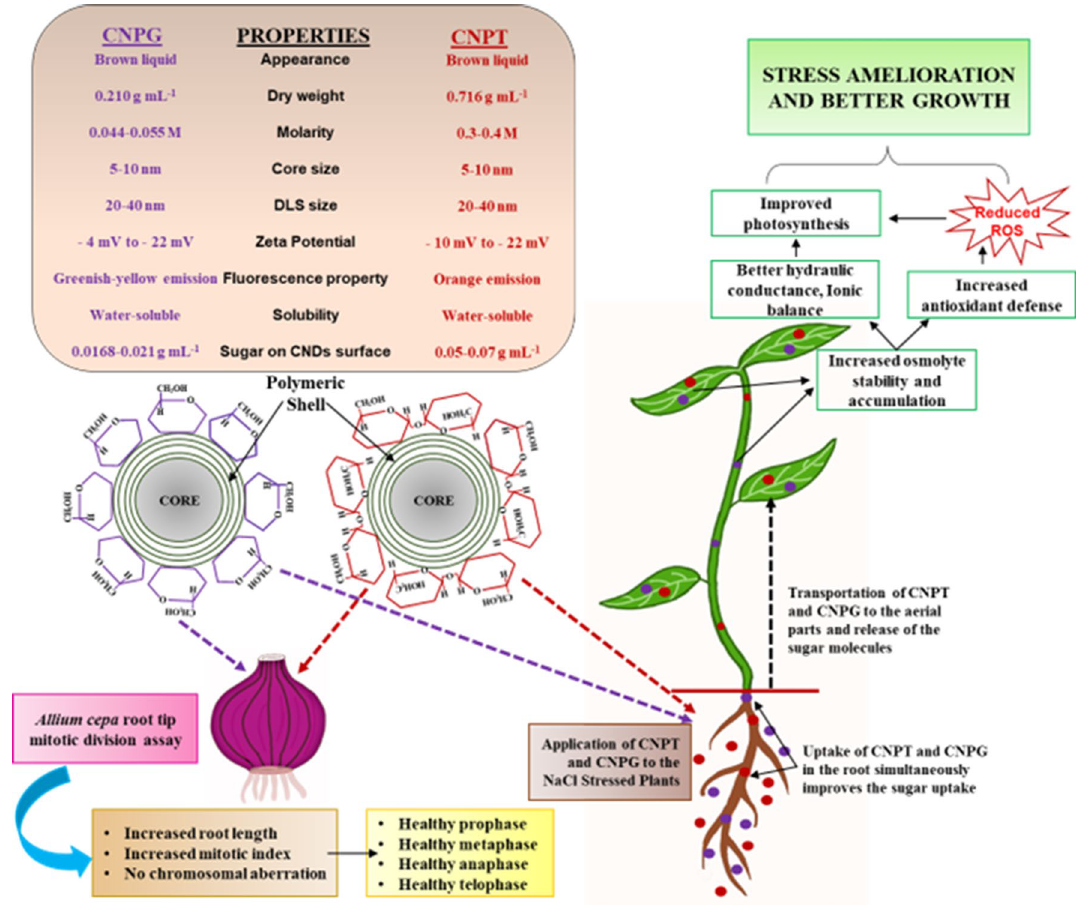
Figure 8. Schematic representation showing the structural and functional attributes of the CNDs and the brief mechanism associated with the alleviation of NaCl stress in Vigna radiata . The application of both CNPT and CNPG reduced the negative impacts of salinity stress by modulating the physiological and biochemical parameters subjected to salinity stress. Briefly, the CNDs facilitated the uptake of sugar molecules, thereby, improving the osmotic status along with the improvement in pigment biosynthesis, antioxidant defense, and ion homeostasis. Moreover, CNDs exhibited no toxicity in the Allium cepa root tip bioassay, indicating their suitability for plant-based